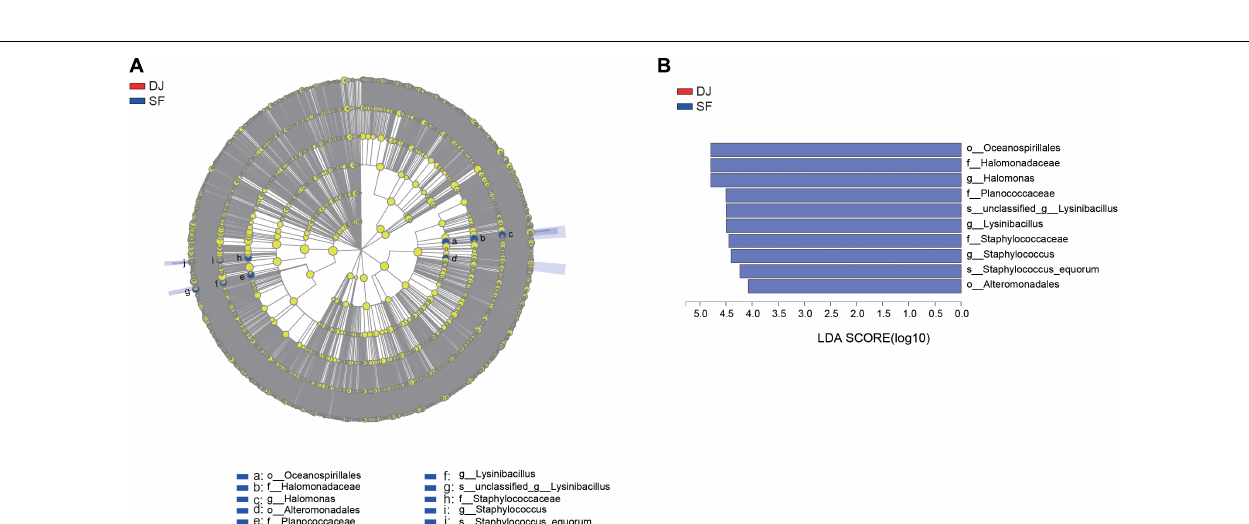
Frontiers in Microbiology |